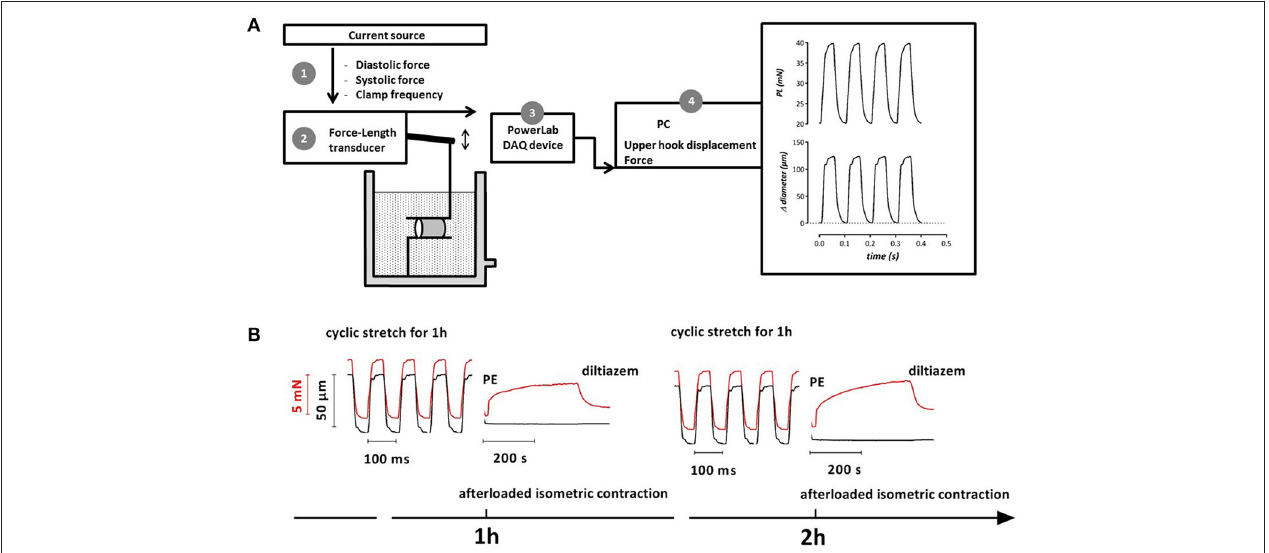
FIGURE 1 | Schematic diagram of the ROTSAC (A) (Leloup et al., 2016) and example of experimental protocol (B) . After mounting the aortic segments a current source was used to control the distension force and clamp frequency of the force-length transducer via the upper hook (1). Force and displacement were measured by the transducer (2) and acquired at 1kHz by a PowerLab DAQ device (3). Diameter, length and force were used to calculate the pressure that would exist in an equilibrated vessel segment with the given dimensions and wall stress (4). (B) Example (1 segment of 1 mouse) of tracings for an experimental protocol to determine vascular reactivity of aortic segments subjected to variable periods of cyclic stretch. Segments were stretched at a frequency of 10Hz to alternating preloads (red, 20–28mN in this condition). The corresponding diameter change is shown in black. After 1h cyclic stretch, the segment was afterloaded to measure the isometric contraction induced by 2 µ M PE and subsequent relaxation by 35 µ M diltiazem. The same measurements could be performed at later time points (2h, 3h, or